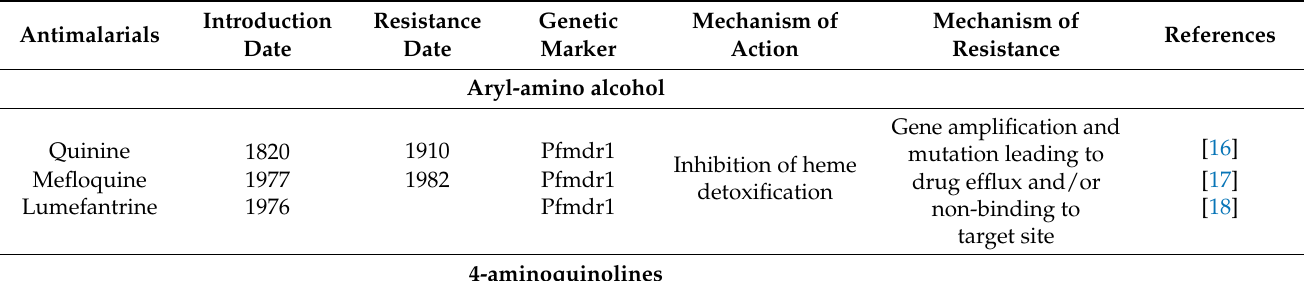
Table 1. Antimalarial